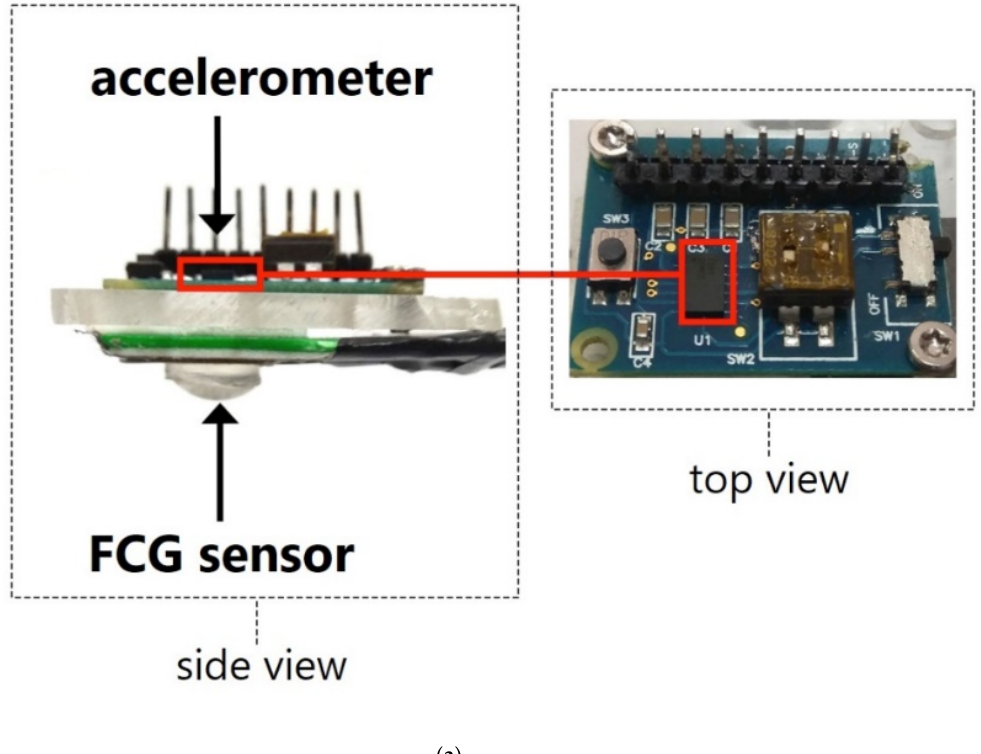
Figure 1. Force-sensitive resistor (FSR)-based forcecardiography (FCG) sensor.